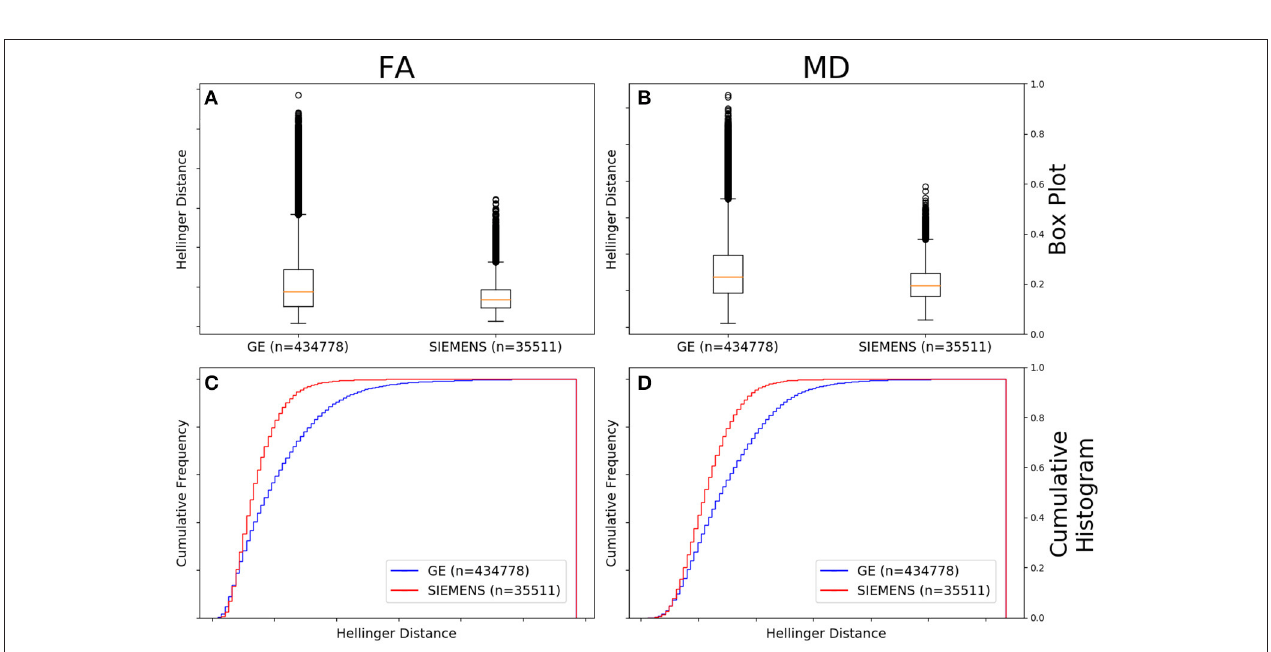
FIGURE 5 | FA (A) and MD (B) map box-and-whisker plot for GE (number of comparisons = 434,778) vs. Siemens (number of comparisons = 35,511) histogram distances for data collected with a b -value of 1,000 s/mm 2 . Cumulative histograms for these data are shown for FA (C) and MD (D) .